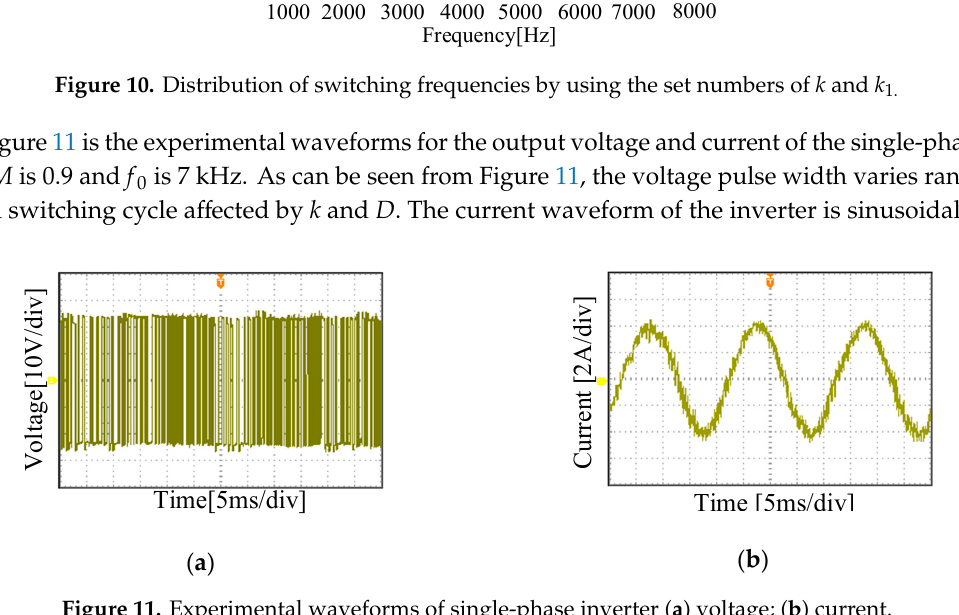
Figure 11. Experimental waveforms of single-phase inverter ( a ) voltage; ( b ) current.